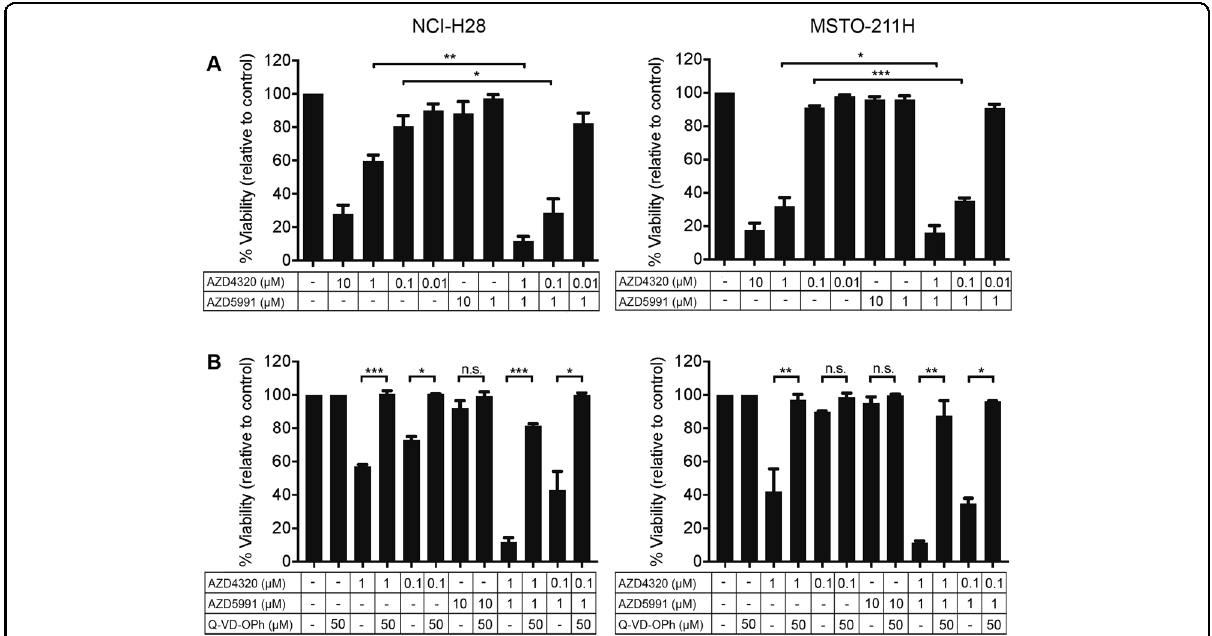
Fig. 2 AZD4320 induces apoptosis in MPM cell lines. A Indicated cell lines were treated with AZD4320, AZD5991, or both for 72 h, and apoptosis induction monitored by FACS using Annexin V / propidium iodide staining. B Apoptosis induction was con fi rmed by treating cells with drugs as single agents and in combination in the presence of the pan-caspase inhibitor Q-VD-OPh. Data represent mean ± SEM ( n = 3) * p ≤ 0.05, ** p ≤ 0.01 and *** p ≤ 0.001 (unpaired Students t